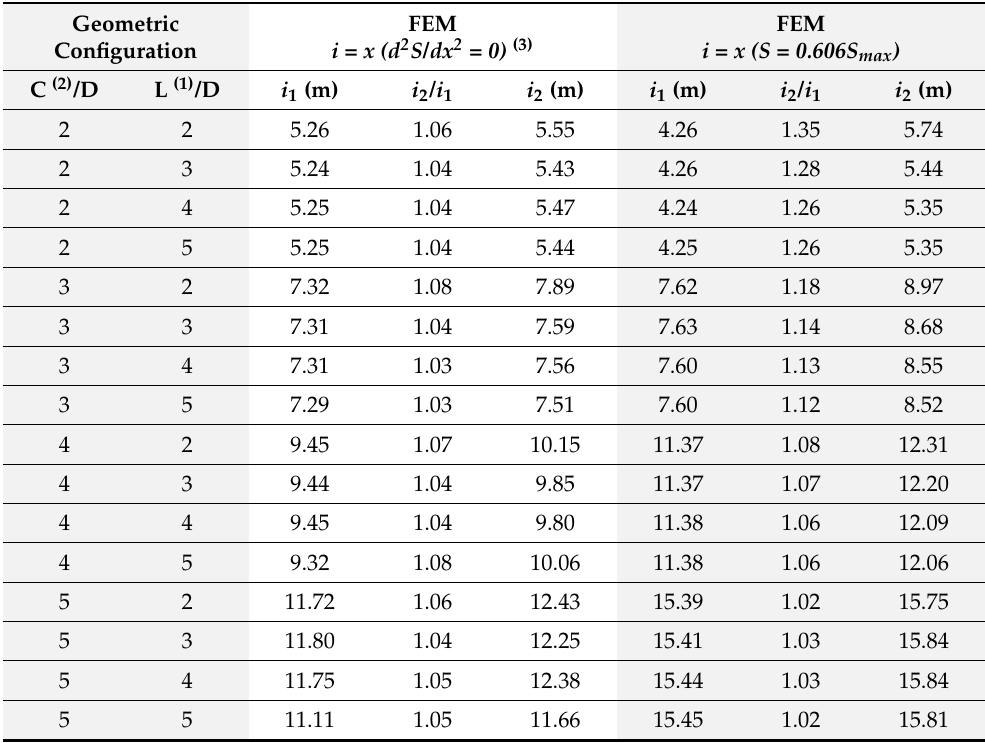
Table 4. Numerical analyses settlement trough.